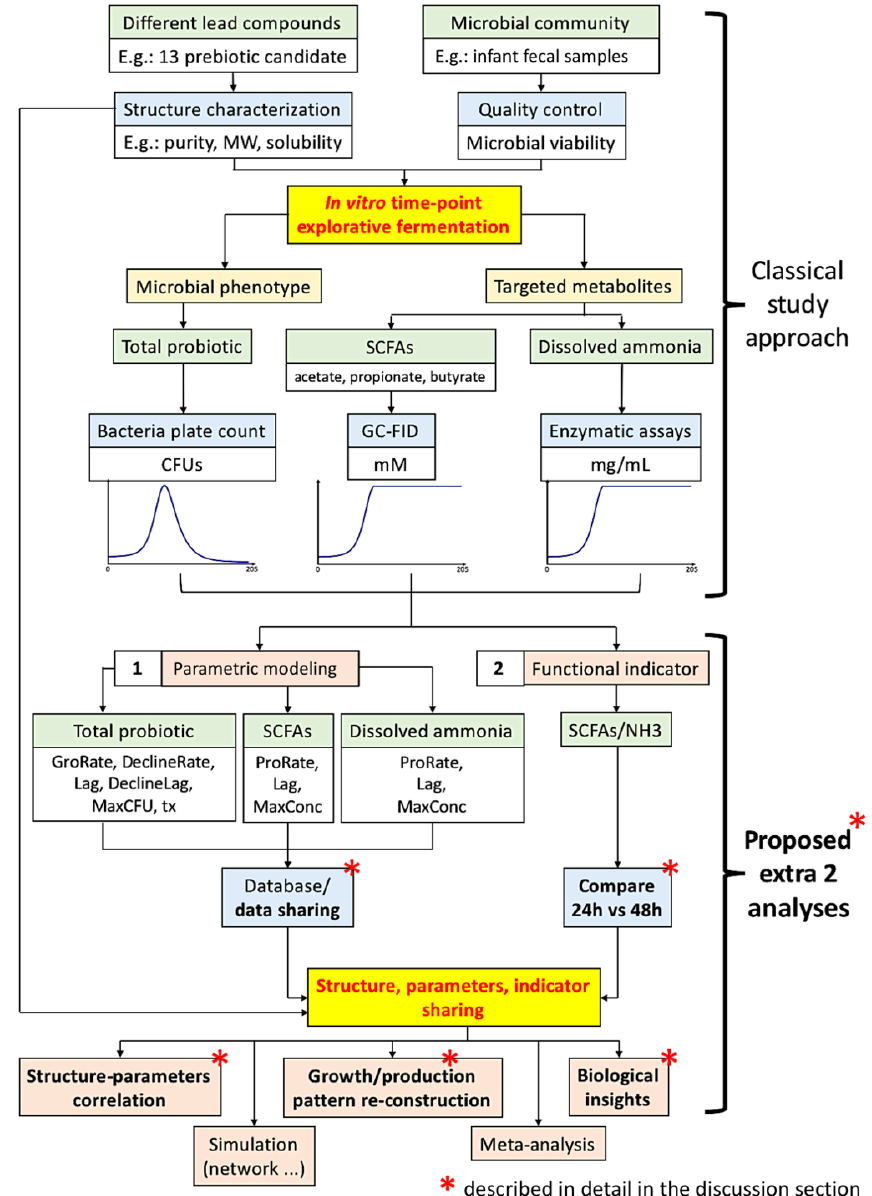
Figure 1. Proposed framework with an extra two analyses procedures together with the classical investigation approach to obtain more in-depth biological insights. The two additional analysis procedures include (1) parametric modeling of the microbial community population pattern and metabolite (short-chain fatty acids, SCFAs, and dissolved ammonia, NH 3 ) production patterns; (2) the calculation of a microbiota functional indicator based on metabolites. Database construction and / or data sharing is also important to further potentiate the novel insights obtained and aid meta-analysis. The whole framework can also be adopted for a personalized evaluation of prebiotics, such as for infants. Commensal bifidobacteria are enumerated as total